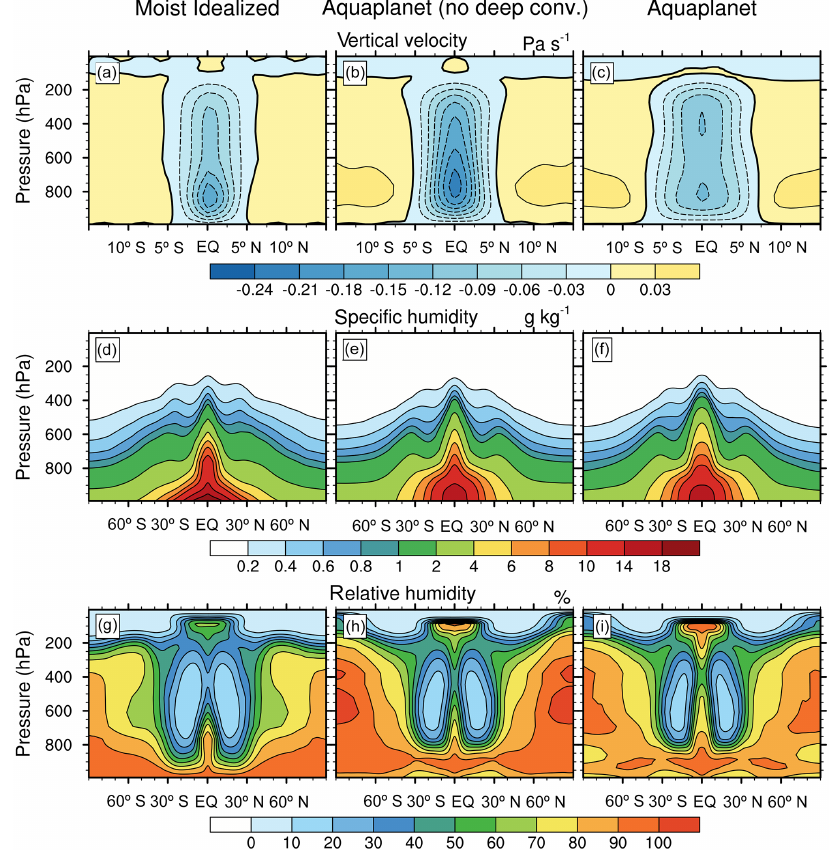
Figure 2. Comparison of CAM5-SE latitude–pressure cross sections in MITC (left column), APS (NDC) (middle column), and APS (right column): time-mean zonal-mean (a, b, c) vertical pressure velocity ω , (d, e, f) specific humidity, and (g, h, i) relative humidity. Note that the latitude range for ω is 15 ◦ S to 15 ◦ N and the color scale for specific humidity is